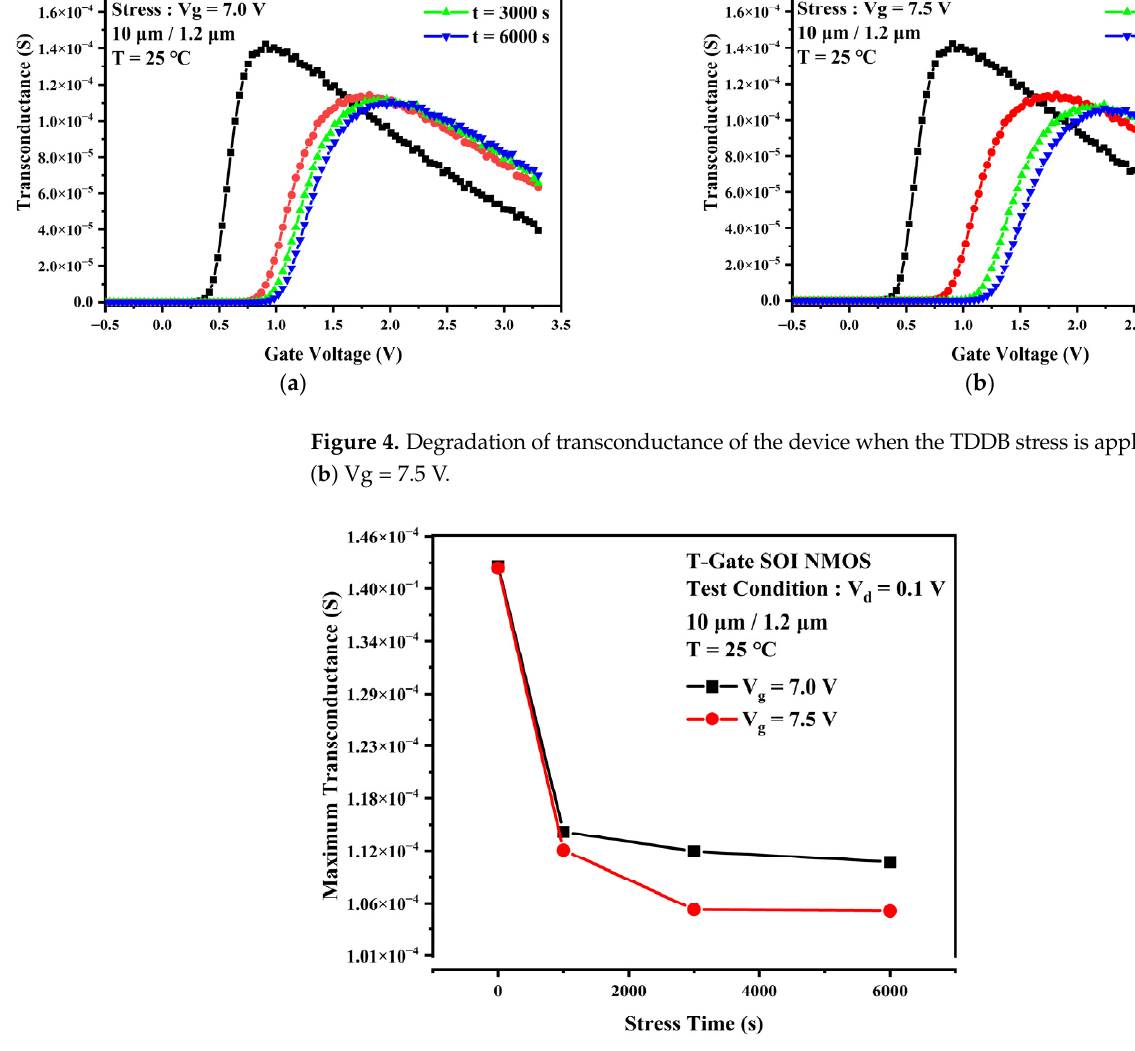
Figure 5. Degradation of the maximum value of device transconductance when TDDB stress is ap-